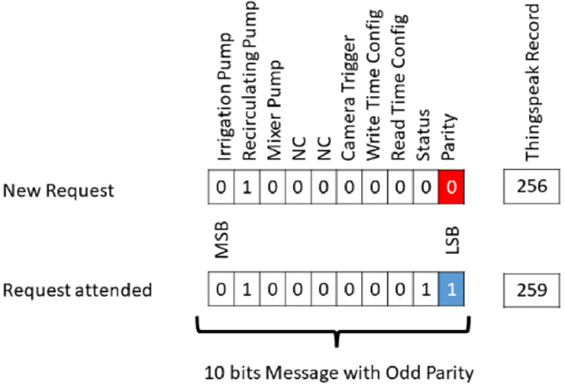
Figure 5. Command vector for remote operation from App.